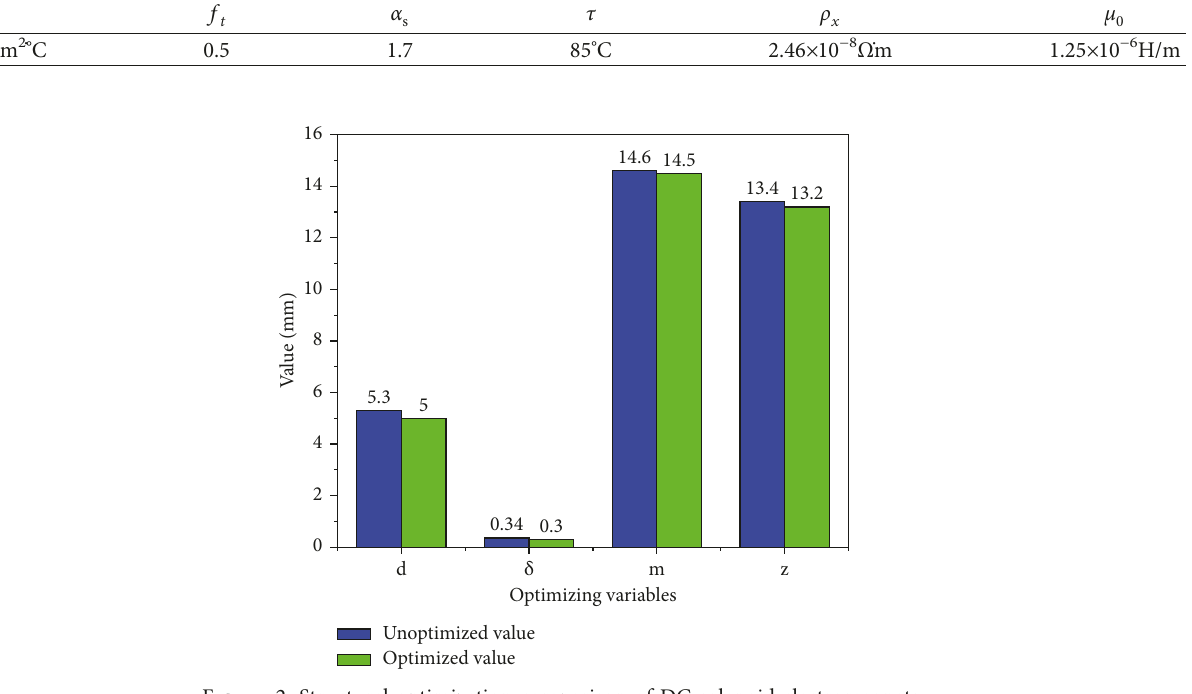
Figure 2: Structural optimization comparison of DC solenoid electromagnets.